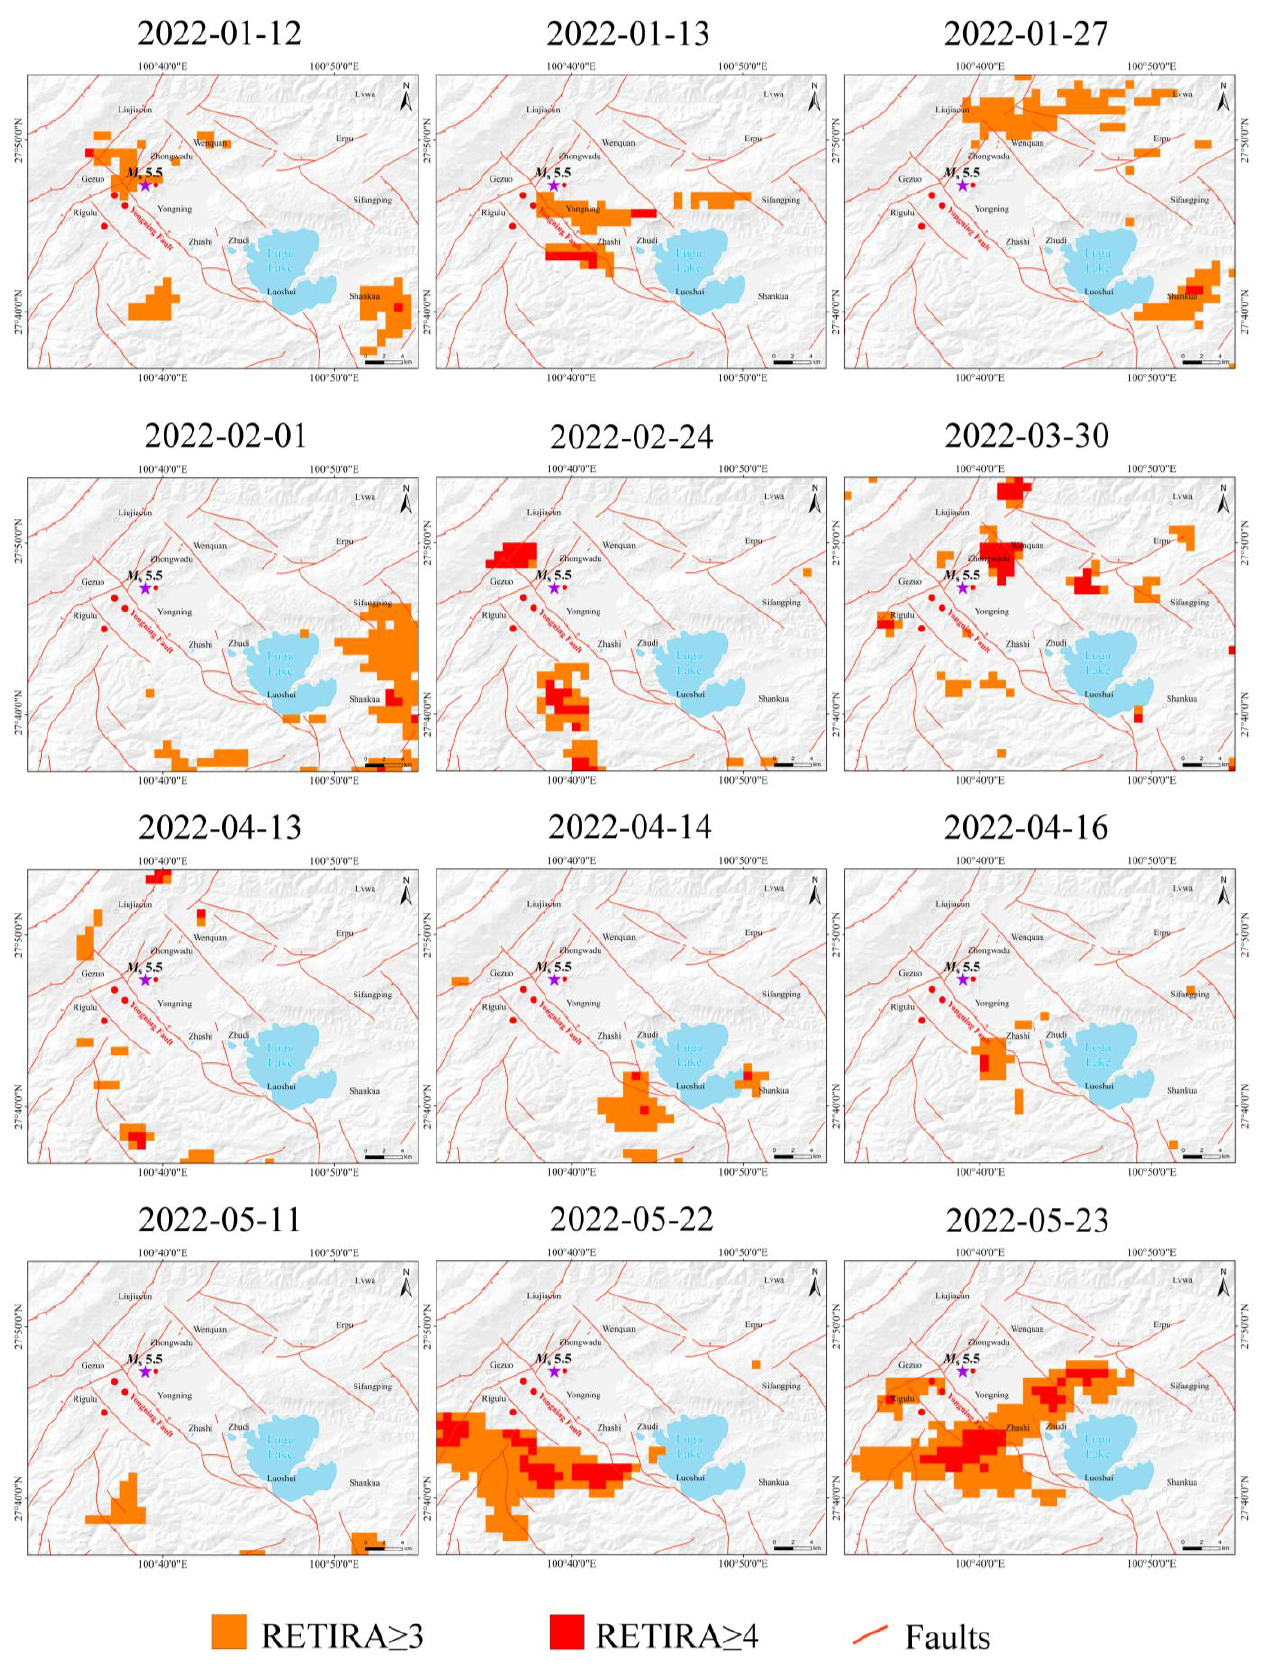
Figure 11. The RETIRA thermal anomalies after the M s 5.5 earthquake on 2 January 2022. The pur- ple stars and red circles are the epicenters in January and April, respectively.